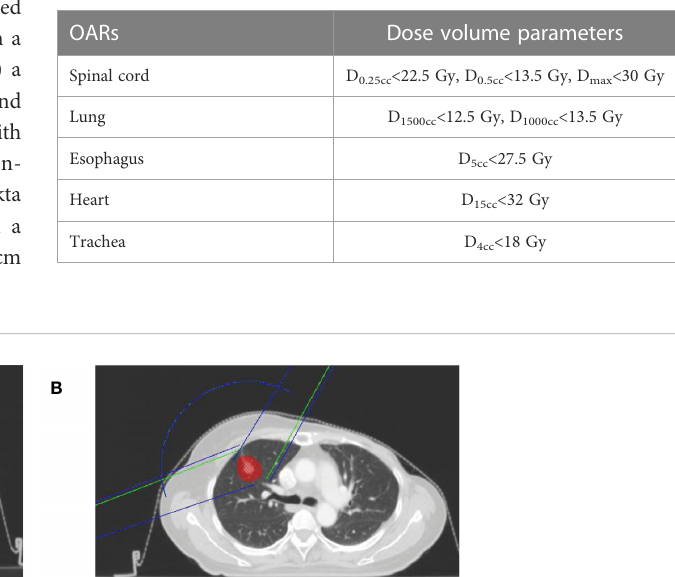
TABLE 2 Dose-volume constraints for